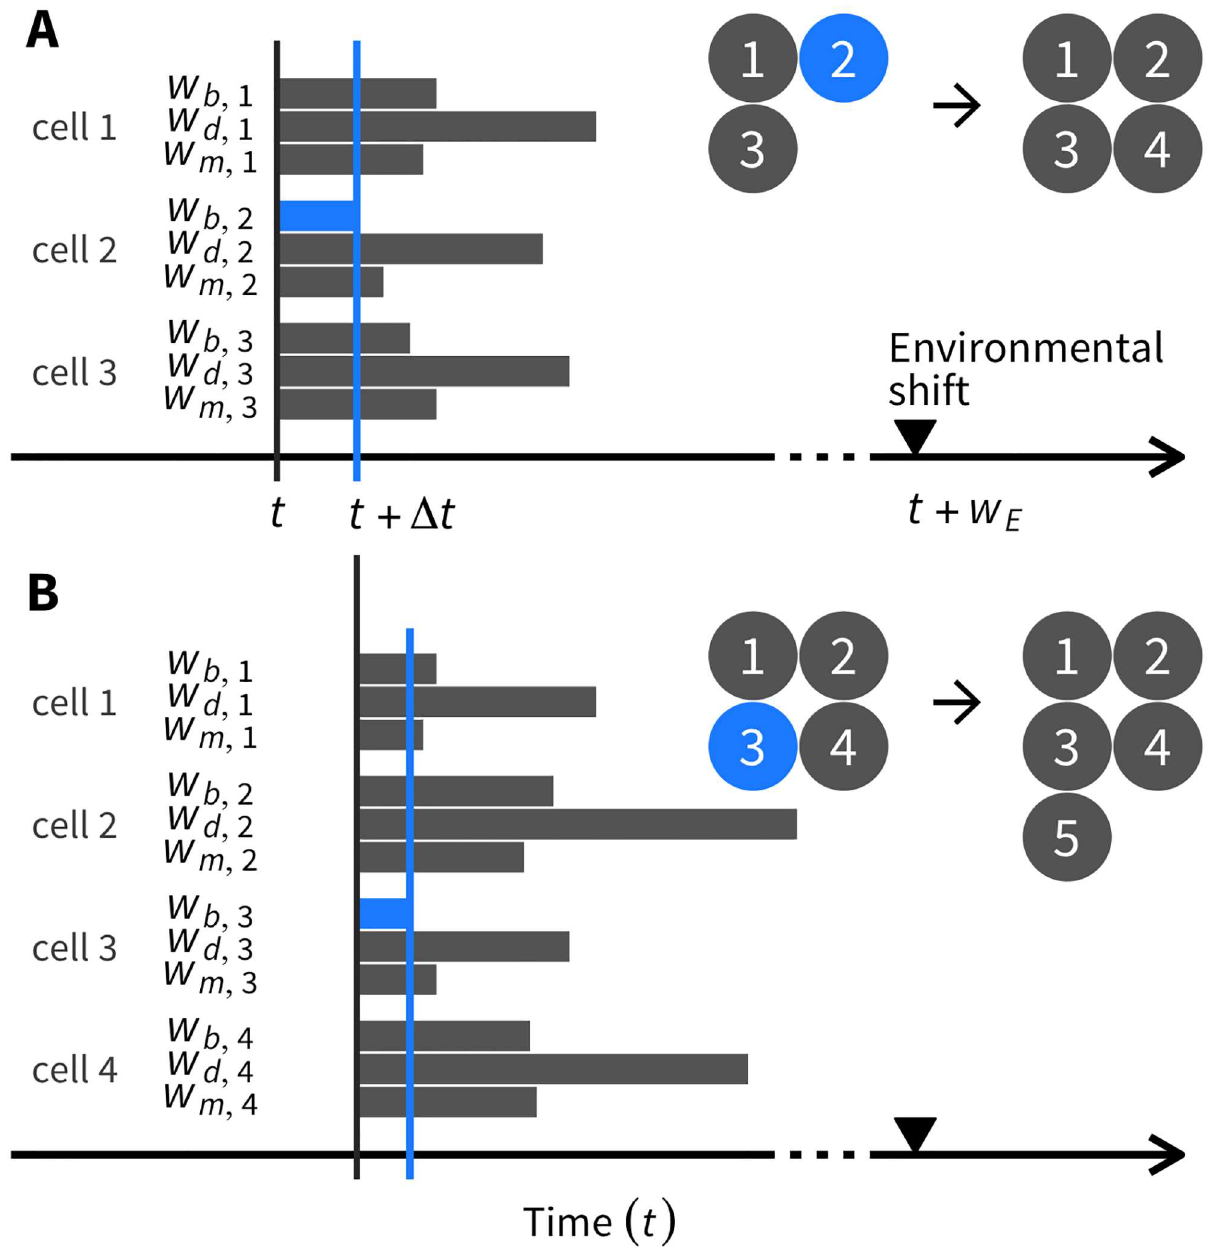
Fig 1. Illustration of the simulation algorithm for determining the next event. (A) An examplewith three cells, 1, 2, and 3 ( N t = 3). The three waiting times are randomly generatedfor each cell as elaboratedin the main text. Because w b , 2 is the smallest (blue), the next event is cell divisionof the second cell, which gives birth to the fourth cell. (B) Again, the waiting times are computedfor all four cells. Note that the waiting times have to be newly generatedfor second and fourth cells that just experienceda cell division,whereas we can reuse the waiting times for the first and third cells with Δ t subtracted. Because w b , 3 is the smallest (blue), the next event is cell divisionof the third cell, creating the fifth cell.